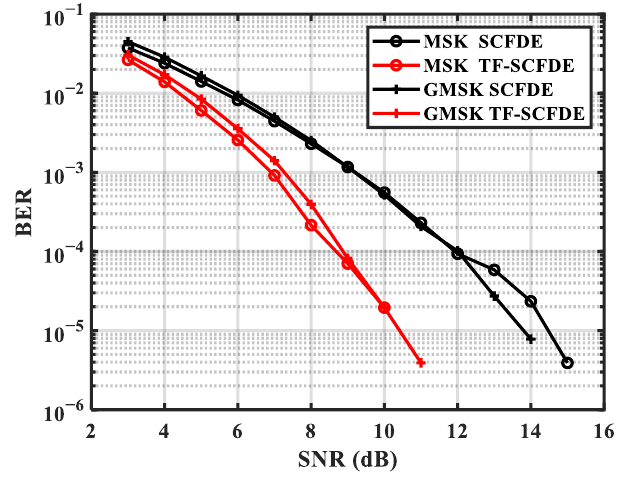
Figure 7. BER for ChA .